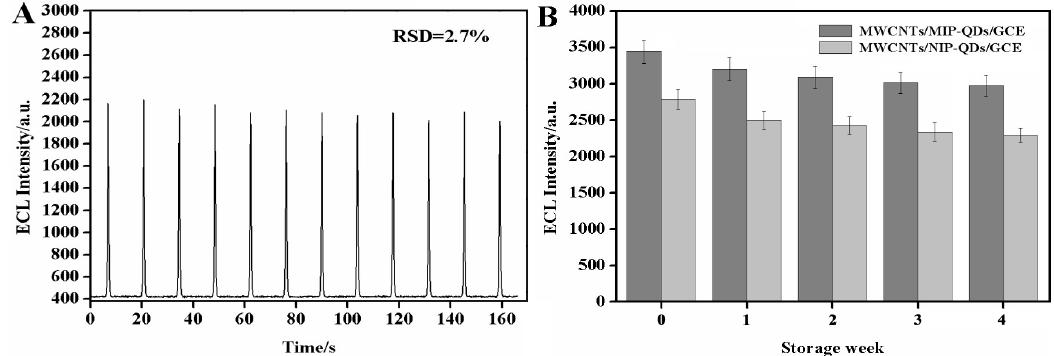
Figure 10. ( A ) ECL stability of the MIECL sensor with 10.0 µg/L CYF in PBS (100.0 mmol/L, pH 9.0) containing 20.0 mmol / L H 2 O 2 ; ( B ) Storing stability of the sensor for 0–4 weeks. containing 20.0 mmol/L H 2 O 2 ; ( B ) Storing stability of the sensor for 0–4 weeks.